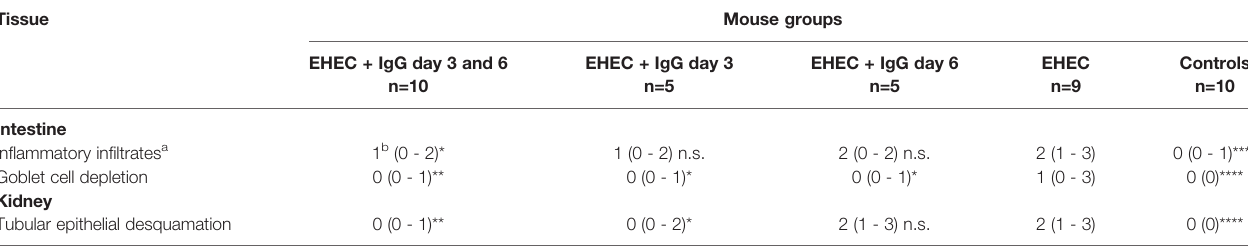
TABLE 1 | Intestinal and renal pathology in E. coli O157:H7-infected mice or uninfected mice. Tissue